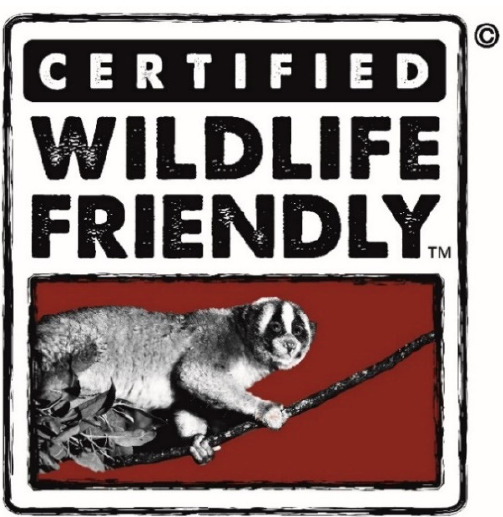
Figure 1. Certification obtained from the Wildlife Friendly Enterprise Network TM by the Little Fireface Project and coffee farmers included in the program evaluated in this study. This logo represents a Javan slow loris ( Nycticebus javanicus ), a Critically Endangered species whose conservation is central to the Little Fireface Project.